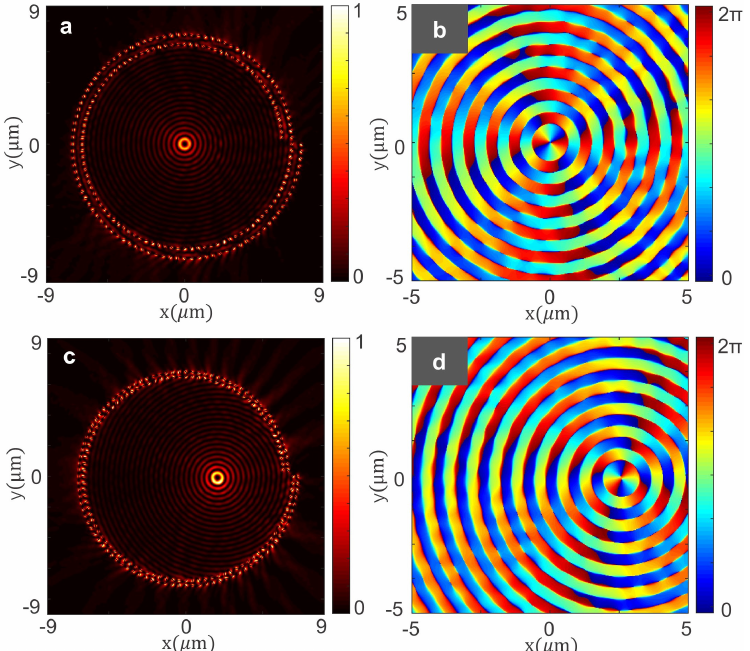
Figure 2. Generation of the tunable plasmonic vortices through varying spacing of the paired nanoslits. ( a ) Intensity and ( b ) phase distribution of the SPP wave with the distance d = λ spp , demonstrating the generation of a centrally-located vortex. ( c , d ) Same as ( a , b ) but the distance d = λ spp